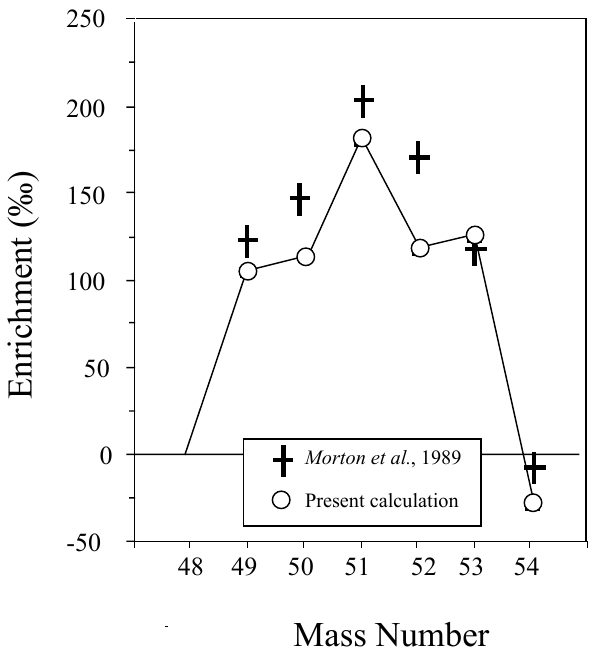
Table 2. Comparison between the rate constants measured by Sehested et al. (1998) with the calculations using the parame- ters given in Sect. 4.3. 16 O + 16 O 16 O ( k 1 ), 18 O + 16 O 16 O ( k 2